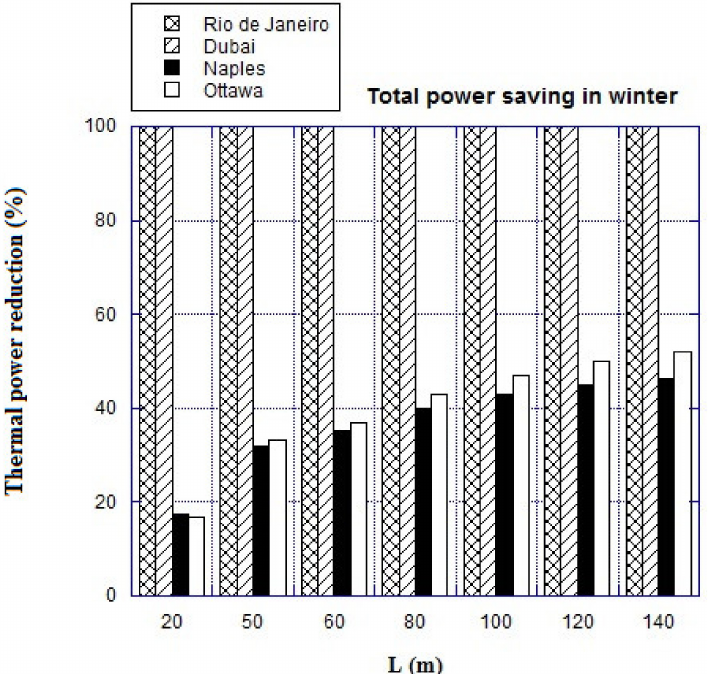
Figure 13. Percentage reduction of thermal power of the coils in the AHU during winter operation mode for the four cities by varying the length of the buried pipes of the GAHX and fixing the air flow velocity to 2.5 m s − 1